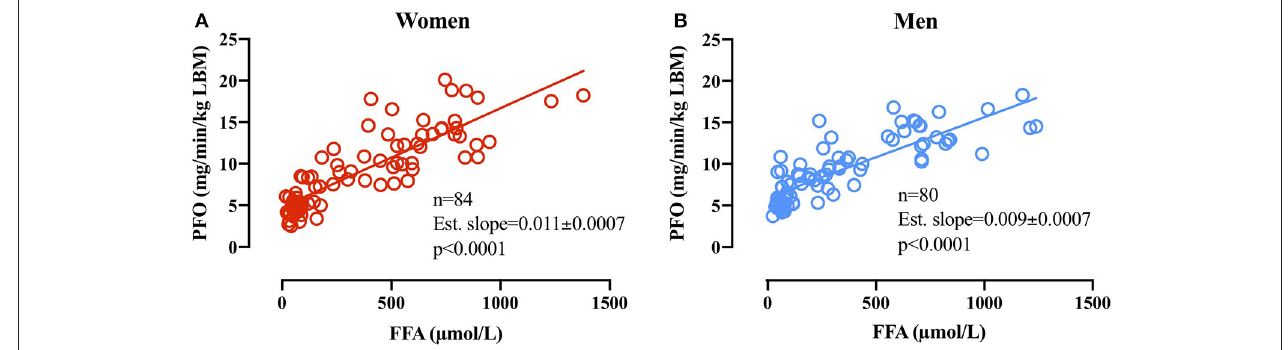
FIGURE 5 | (A) Relative PFO (mg/min/kg FFM) plotted against basal plasma FFA concentrations ( µ mol/L) before subsequent GXT in women (A,B) men. Due to technical issues, four basal blood samples were not obtained in the women (84 basal blood